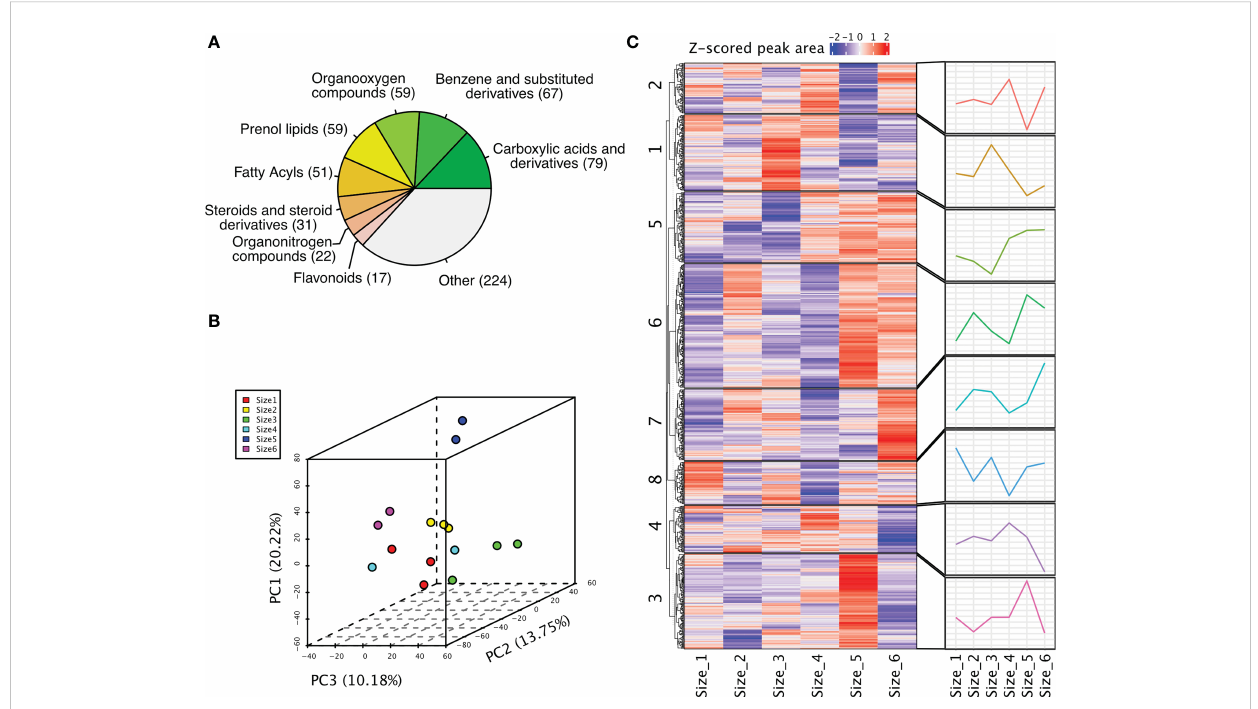
FIGURE 2 Metabolome pro fi ling of rhizomes from P. sibiricum at different growth stages. (A) The major classes of metabolites detected in P. sibiricum rhizomes. (B) Principal component analysis (PCA) of peak areas of metabolites detected in rhizomes from different growth stages. (C) K-means clustering of all detected metabolites in rhizomes from different growth stages. The peak areas were used for clustering. The heatmap depicts the relative abundance of each metabolite in different samples, and the line charts depict the accumulation pattern of metabolites in each